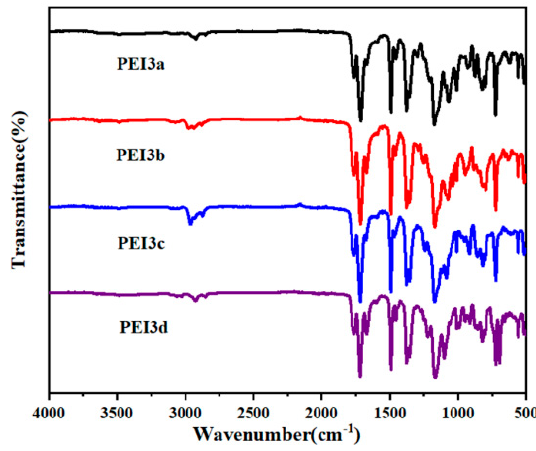
Figure 2. FTIR spectrum of PEI3a–PEI3d.